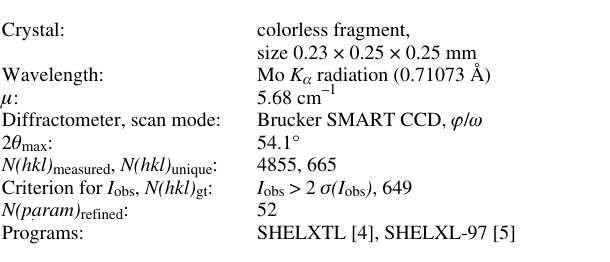
Table 1. Data collection and handling.